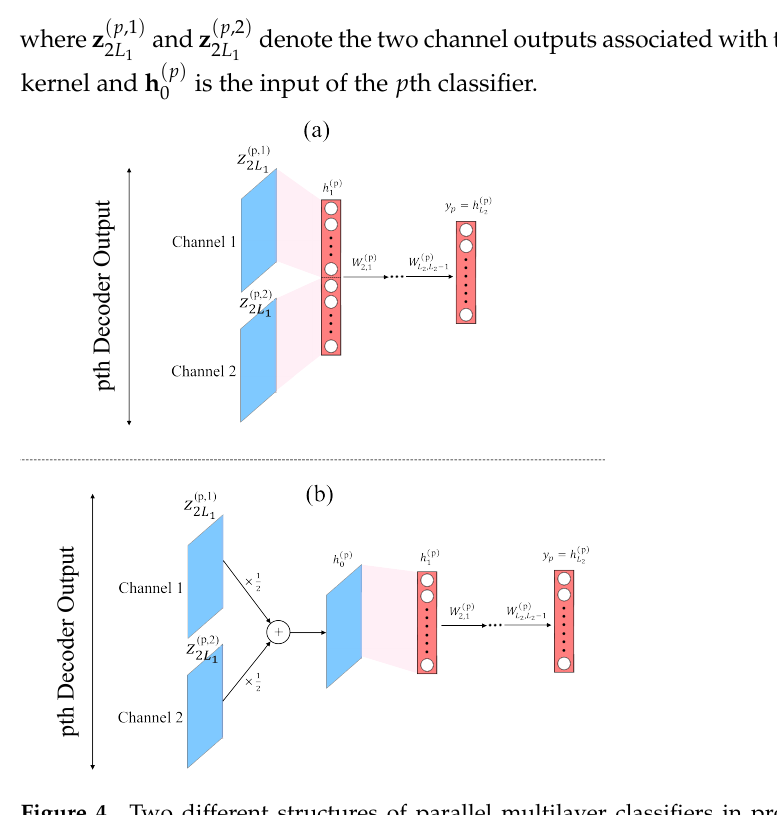
Figure 4. Two different structures of parallel multilayer classifiers in proposed CAE for DOA estimation: ( a ) the structure of direct processing of two channels, ( b ) the structure of merging two